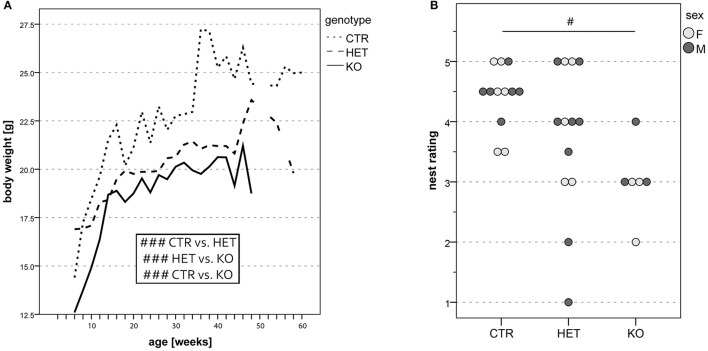
Body weight of mice at different ages. (A) Overall body weight was lower in both KO and HET than in CTR mice. CTR mice were heavier than HET mice, and the latter were heavier than KO mice. Furthermore, male mice were heavier than female mice. Data originate from all mice used for behavioral experiments (n = 55 CTR, 31 HET, 36 KO). Nest assessment: KO mice build nests of lower quality than CTR and HET mice (B). Circles filled in light and dark gray represent data of single female and male mice, respectively. There was no sex difference in the quality of nests built overnight by the individually housed mice, however CTR mice built nests of higher quality than KO mice. Quality ratings were assessed by a blinded observer. (n = 12 CTR, 13 HET, 6 KO). (#p < 0.05, ###p < 0.001).